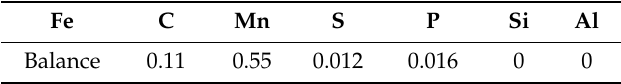
Table 2. Chemical composition (wt.%) of SAE 1010